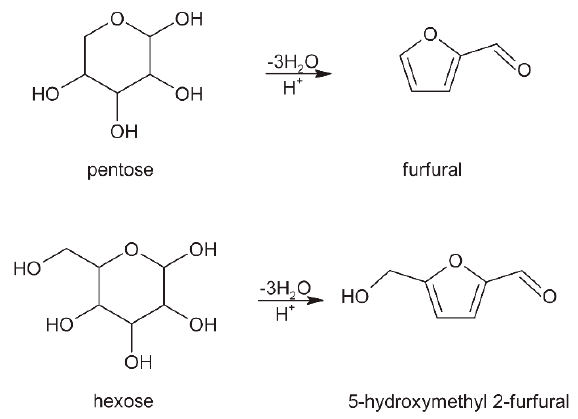
Figure 3. Dehydration of sugars.